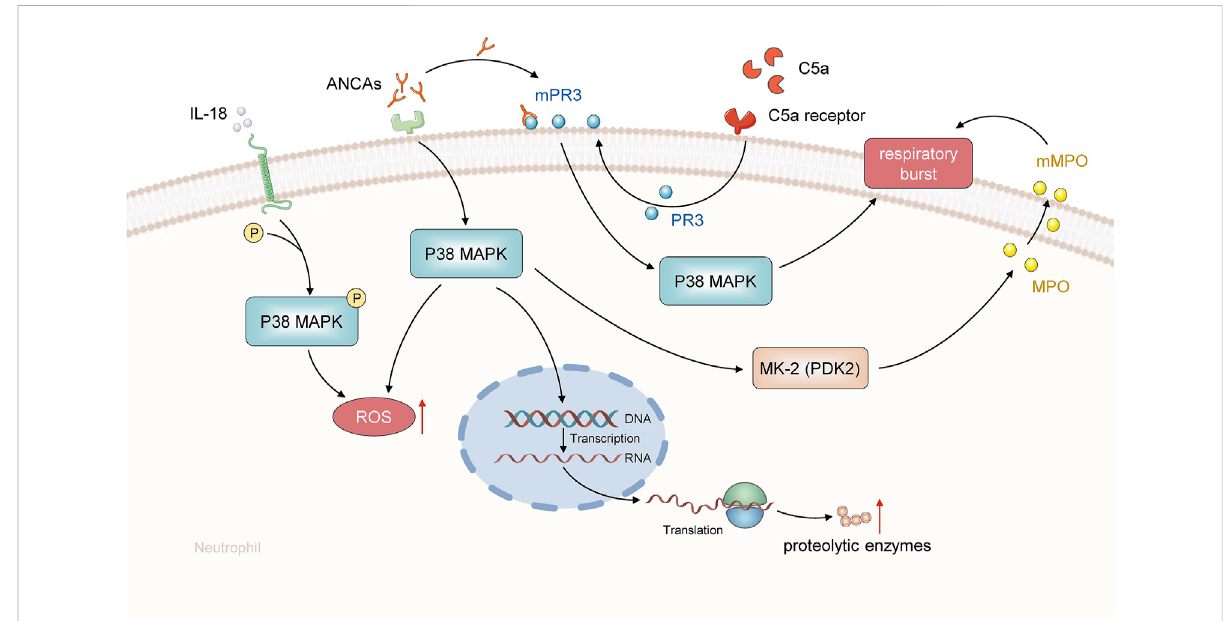
FIGURE 2 MAPK signaling pathway in the pathogenesis of AAV. ANCA activates the p38MAPK-mediated signaling pathway in human neutrophils. This signal cascade is responsible for the translocation of ANCA-speci fi c antigens from the cytoplasmic granulosa to the neutrophil surface. This translocation enablestheseantigenstobindwiththeirspeci fi cautoantibodies.IL-18initiatesANCA-inducedproductionofneutrophilsuperoxideby phosphorylating